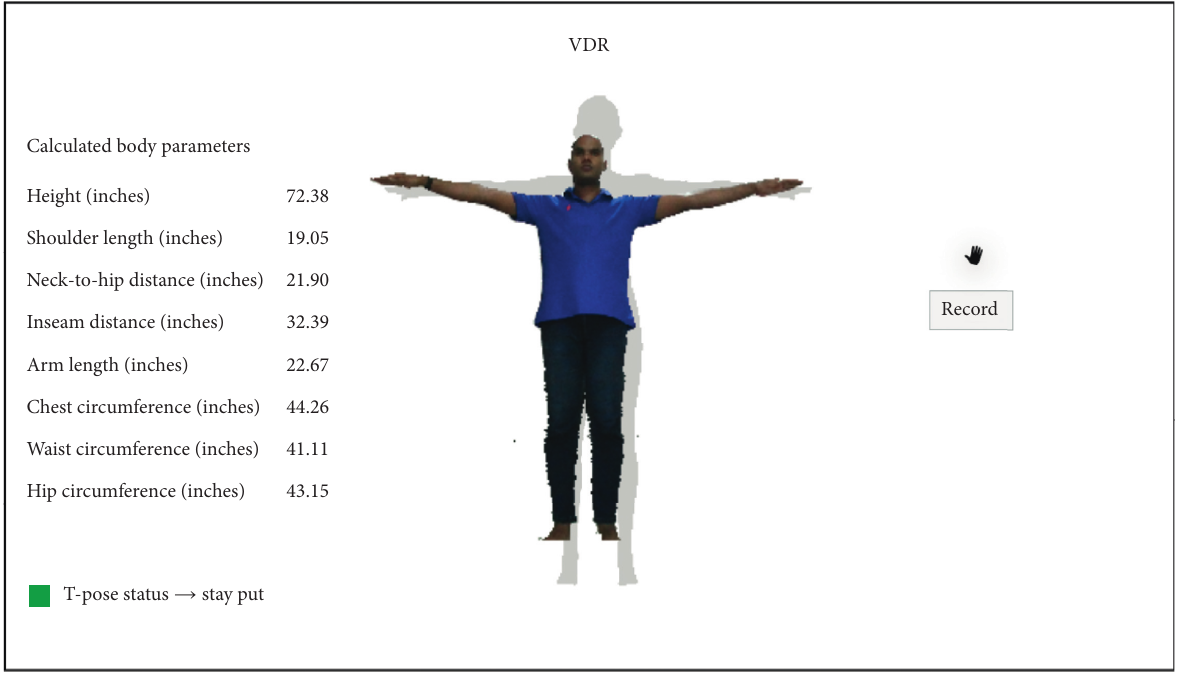
Figure 10: WPF application-noncontact body parameter